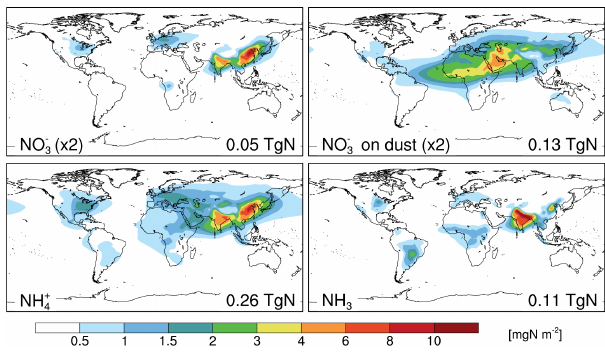
Figure 2. Annual mean burden of NO − NH 3 in mgNm − 2 in AM3N from 2008 to 2010. Global burdens are indicated inset. The location of the Bondville site is indicated by a black cross in the upper left panel.